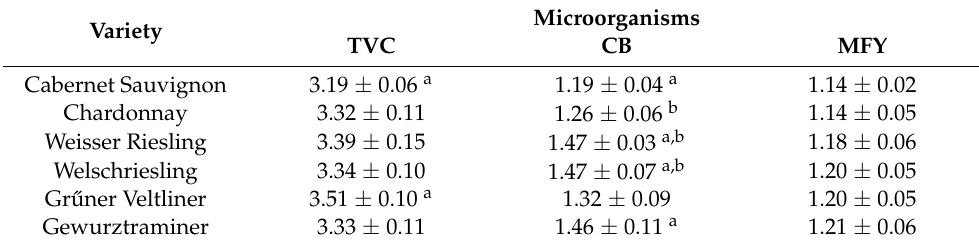
Table 1. Number of different group of microorganisms in log cfu/g. Variety